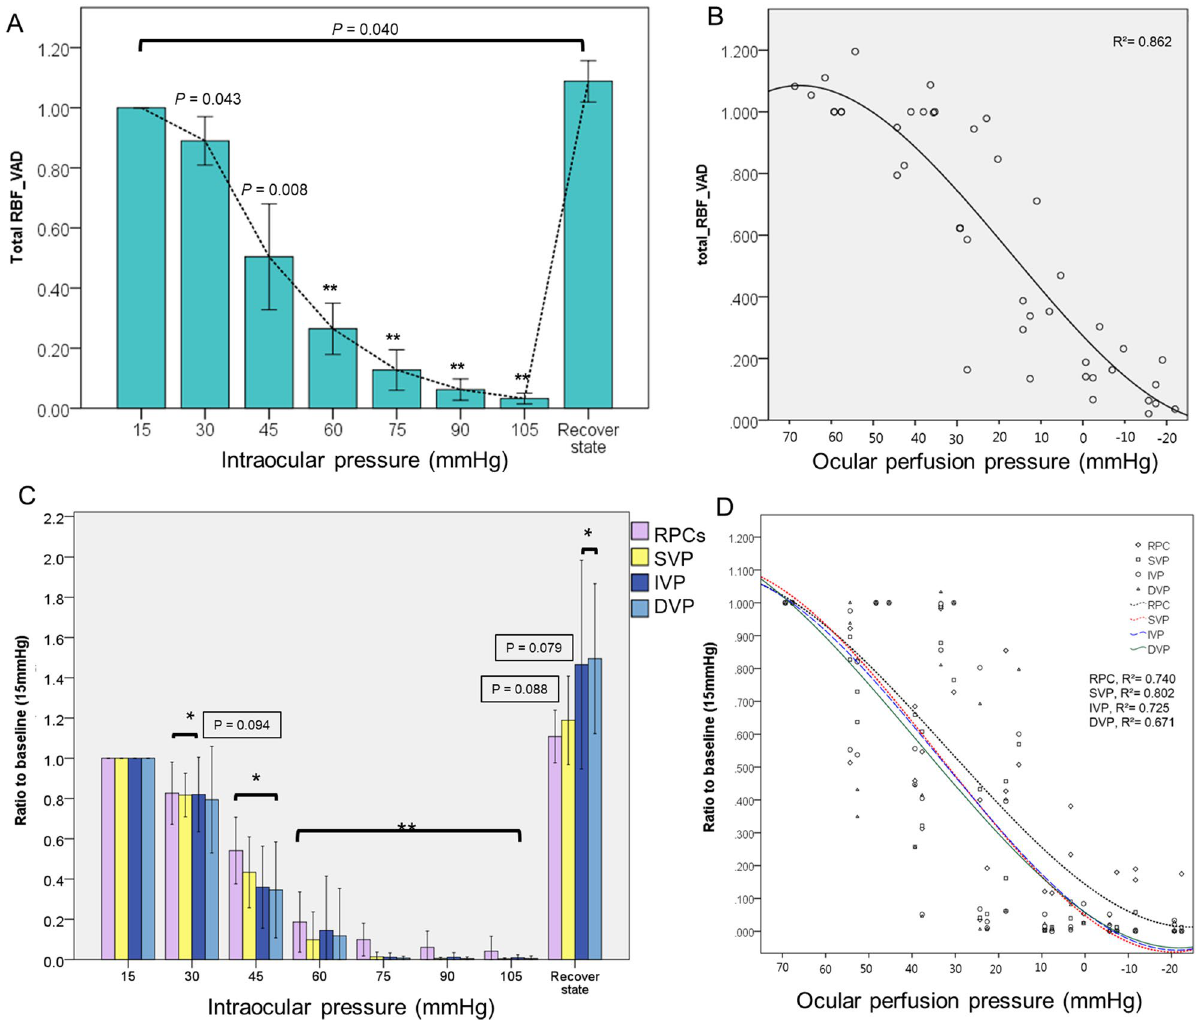
Figure 4. Changes of retinal and choroidal blood flow according to intraocular pressure. ( A ) The relative vessel area density (rVAD) of total retinal blood flow according to intraocular pressure. ( B ) The plotted rVAD of total retinal blood flow according to ocular perfusion pressure. ( C ) The relative vessel area of each retinal capillary layer according to intraocular pressure ( RPCs radial peripapillary capillaries, SVP superficial vascular plexus, IVP intermediate vascular plexus, DVP deep vascular plexus). ( D ) The plotted rVAD of each retinal capillary layer according to ocular perfusion pressure. IOP levels significantly different from the baseline are indicated by * for P < 0.05 and ** for P < 0.01 in ( A , C ). The values of the recovery state is not included in ( B , D